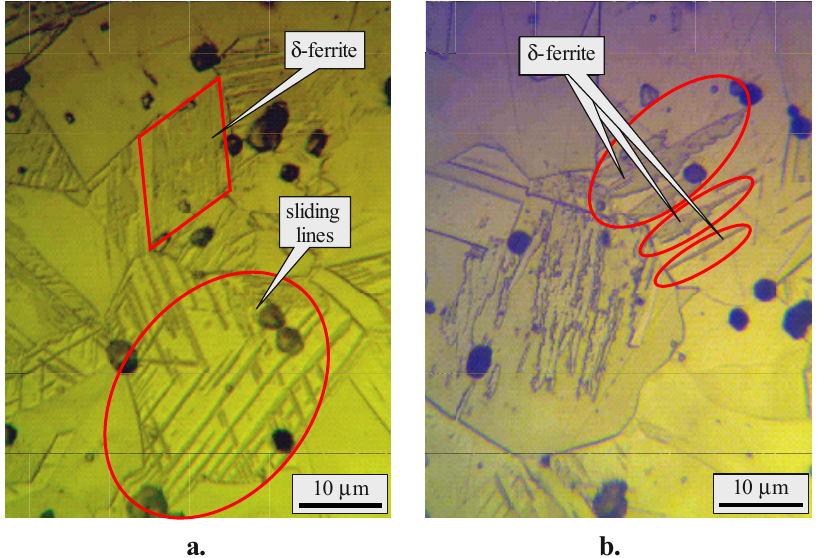
Figure 3. Initial microstructure of AISI 304 steel, magnification × 1000: ( a ) in the subsurface layers; ( b ) in the core.